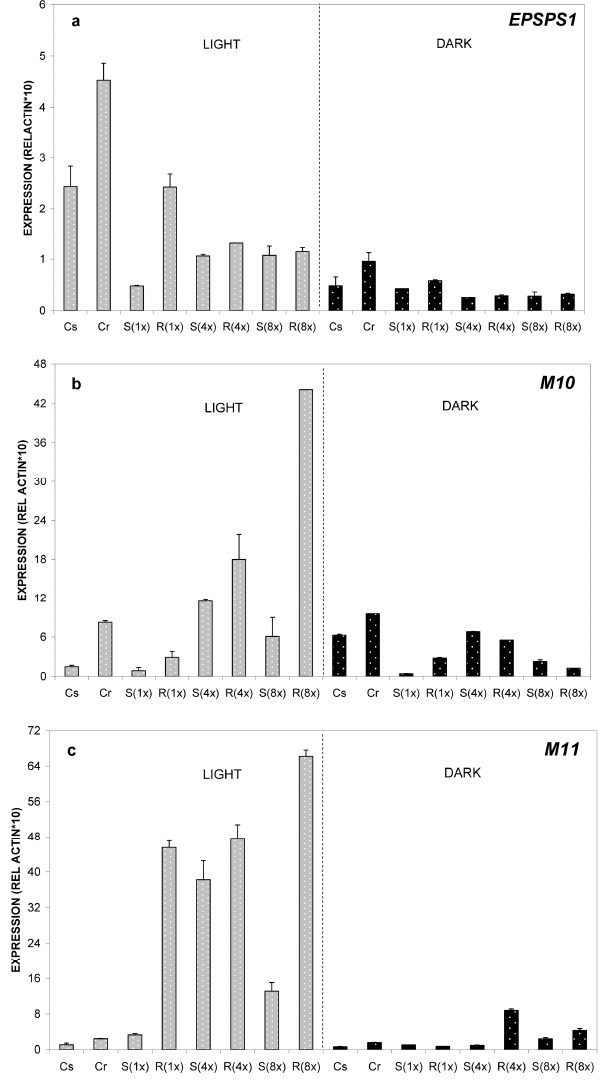
Figure 3. Relative expression profiles of EPSPS1 gene ( a ) and of the ABC - transporter genes M10 ( b ) and M11 ( c ). Samples were taken from plants grown at 35 °C. Relative quantification was obtained through the 2 ΔΔ C t method using actin as the reference gene. Leaves from the untreated (control) plants of the susceptible biotype (Cs) were used as the reference sample. Explanation of samples abbreviations was given on Figure legend 2. Relative expression ratios were estimated after 1 DAT. Data represent the average from three biological replicates and the error bars indicate the standard deviation.